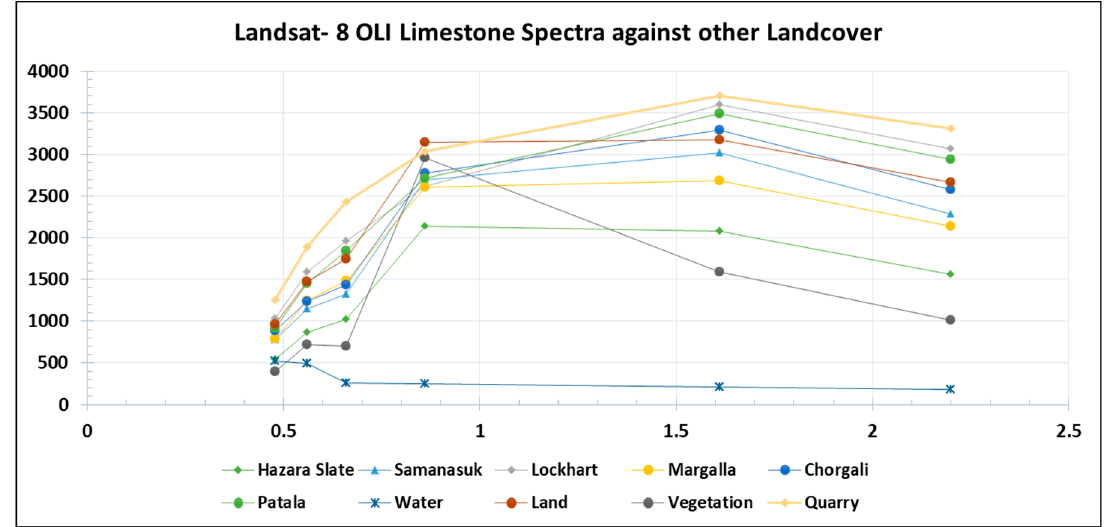
Figure 3. Mean spectral response of features of limestone, water, and vegetation extracted from Landsat-8 for Hattar, Khyber Pakhtunkhwa, Pakistan. Table 3. CART and random forest (RF) overall (OA) and consumer (CA) accuracy for limestone formations classification using training data from the GSP